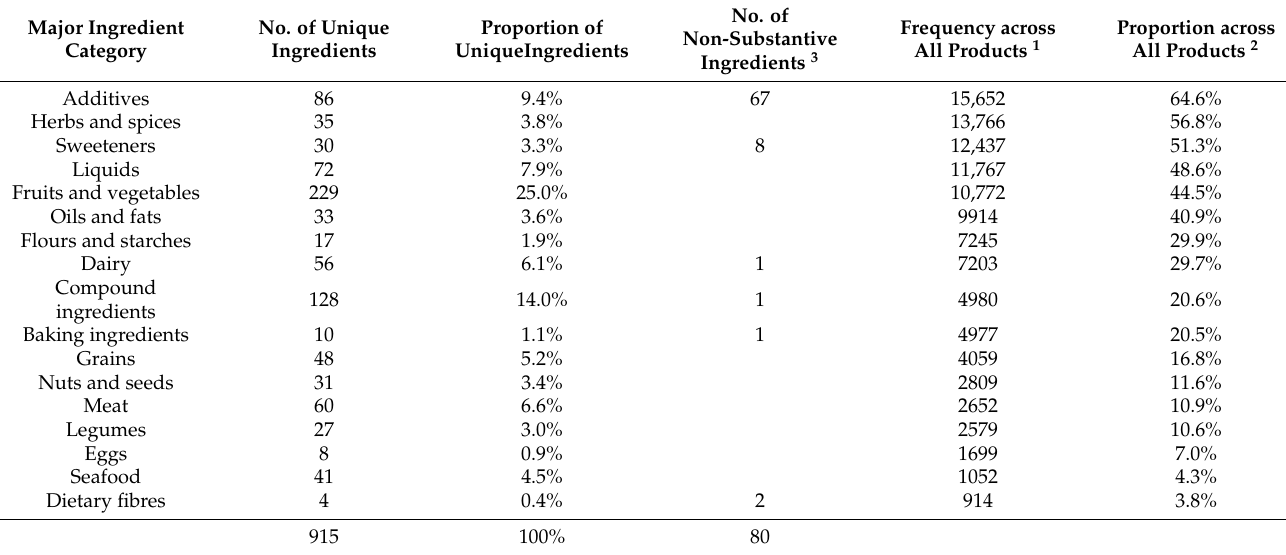
Table 1. Ingredient frequencies by major ingredient category.